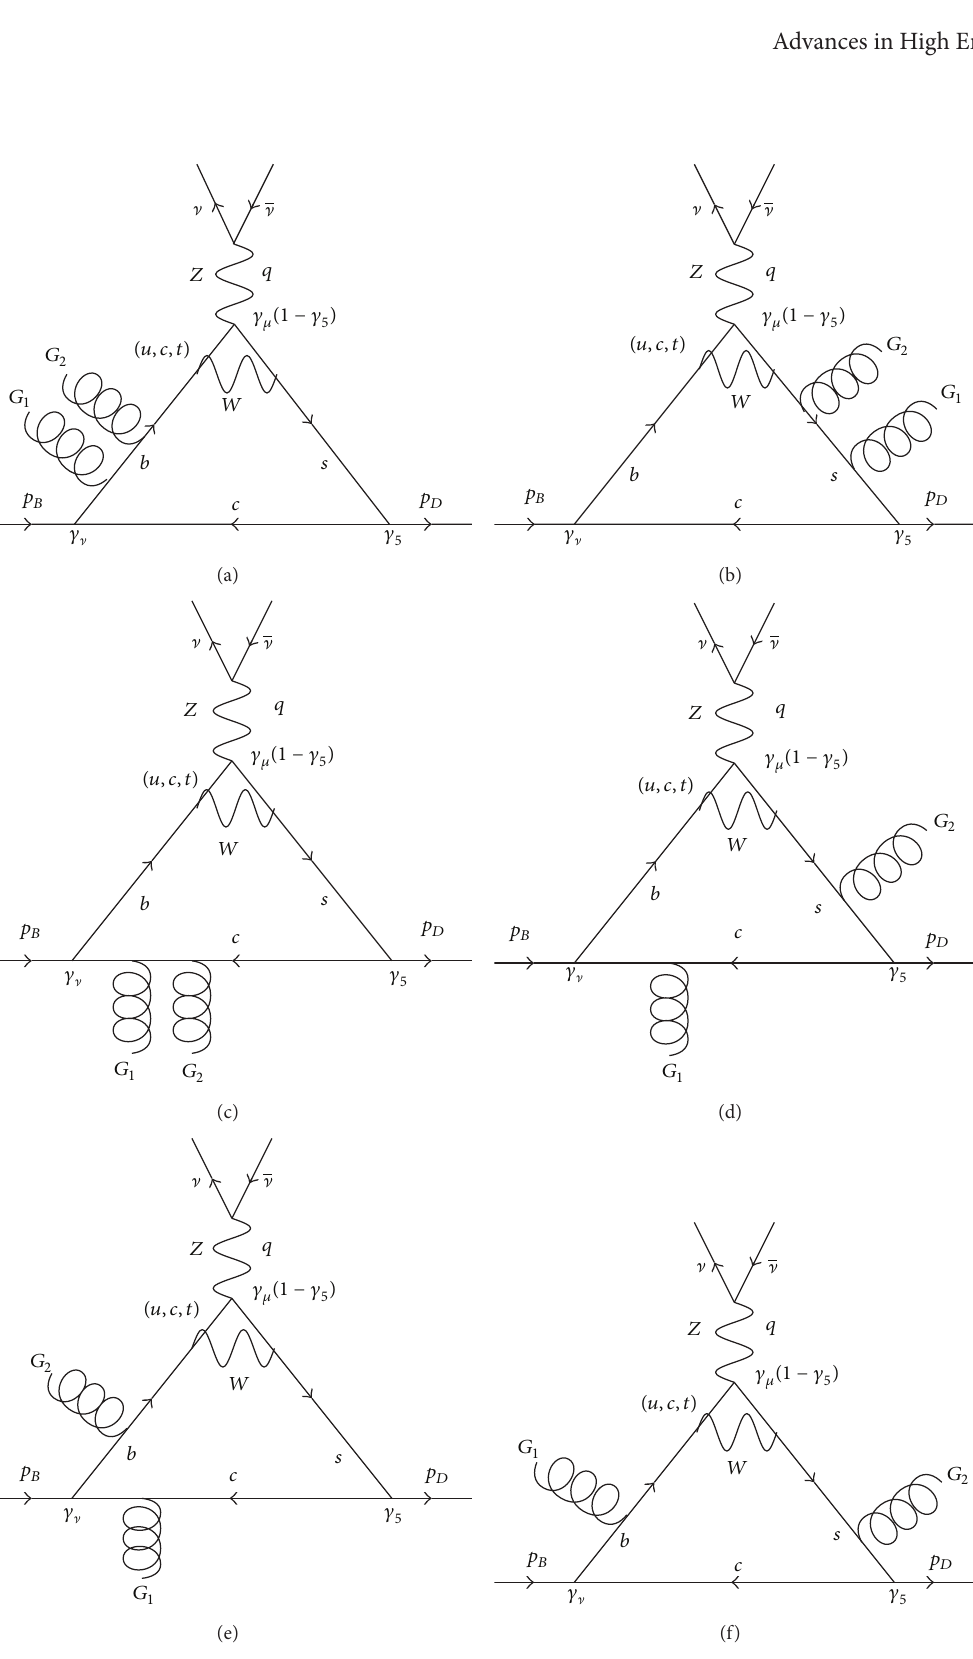
Figure 2: Gluon condensate contributions to 𝐵 ∗ 𝑐 → 𝐷 𝑠 ] + ] −